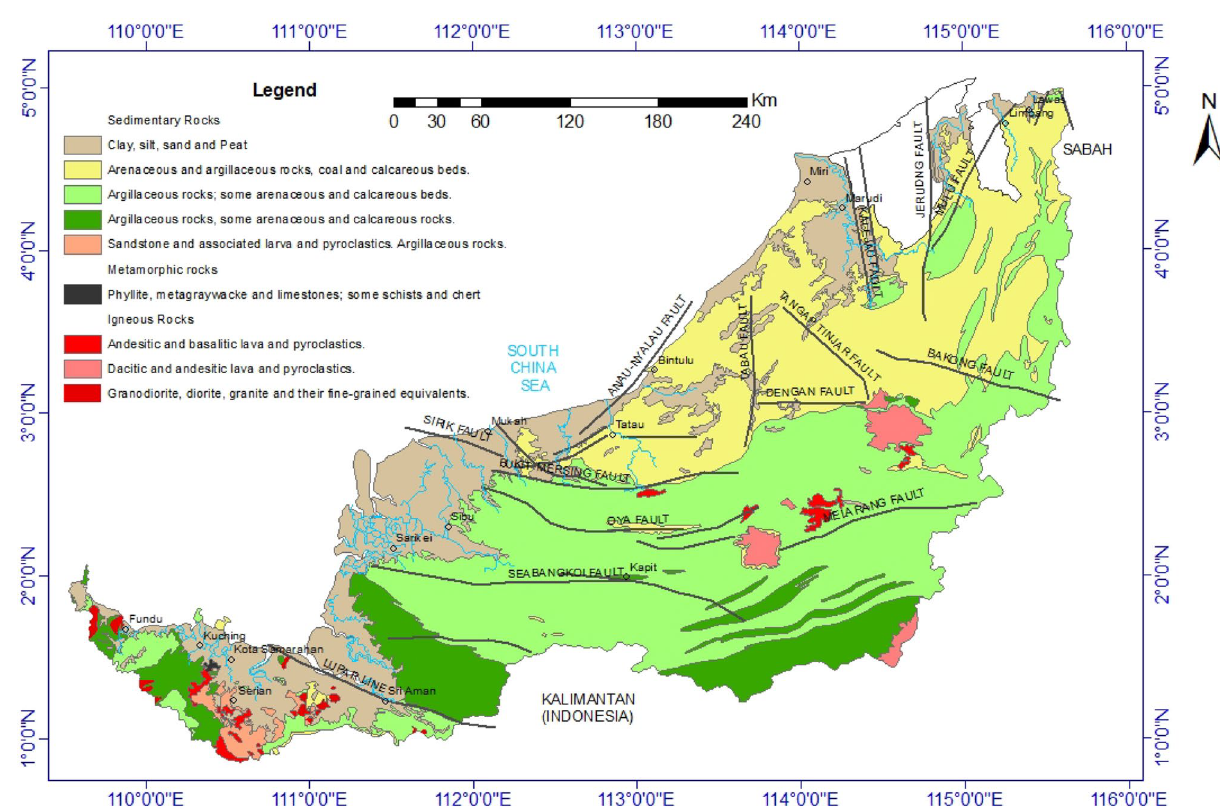
Fig. 3 Simplified geological map of the Sarawak Basin (Modified after Mineral and Geoscience Department of Malaysia